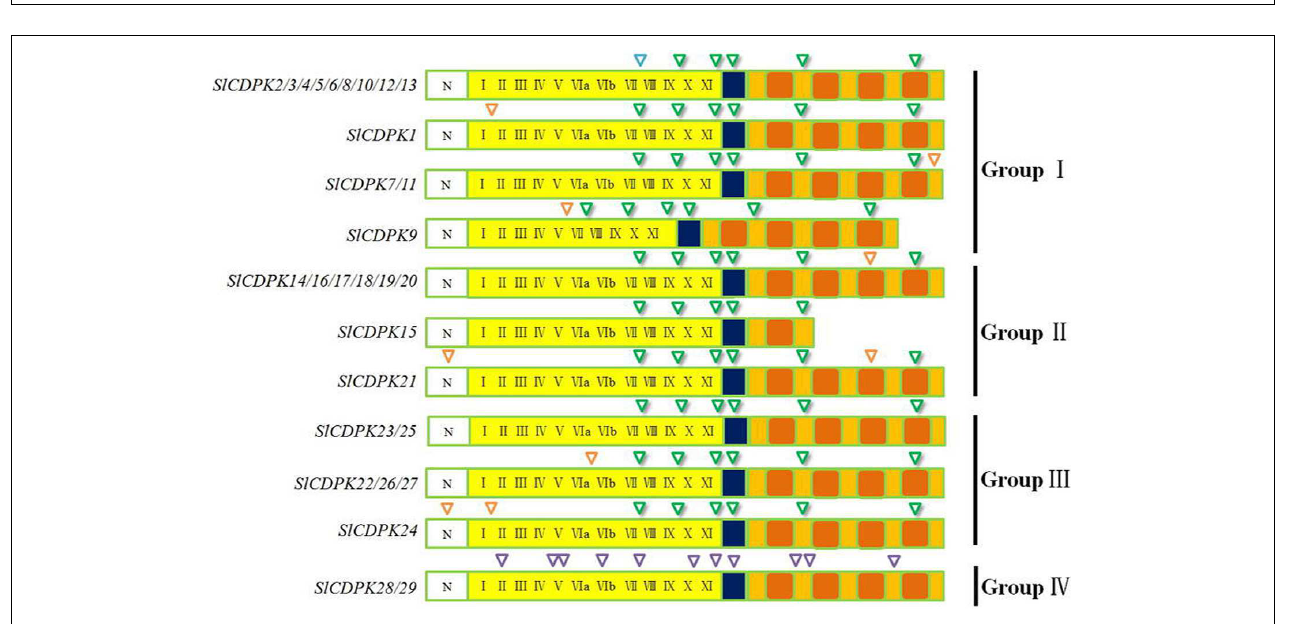
FIGURE 4 | Splicing sites of CDPK genes in tomato. Green inverted triangles represent the basic splicing sites in CDPK genes. Orange inverted triangles represent the special splicing sites in CDPK genes. Purples inverted triangles represent the unique splicing sites in Group IV CDPK genes.